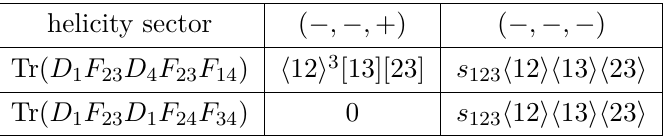
and O 00 8;1 8;2